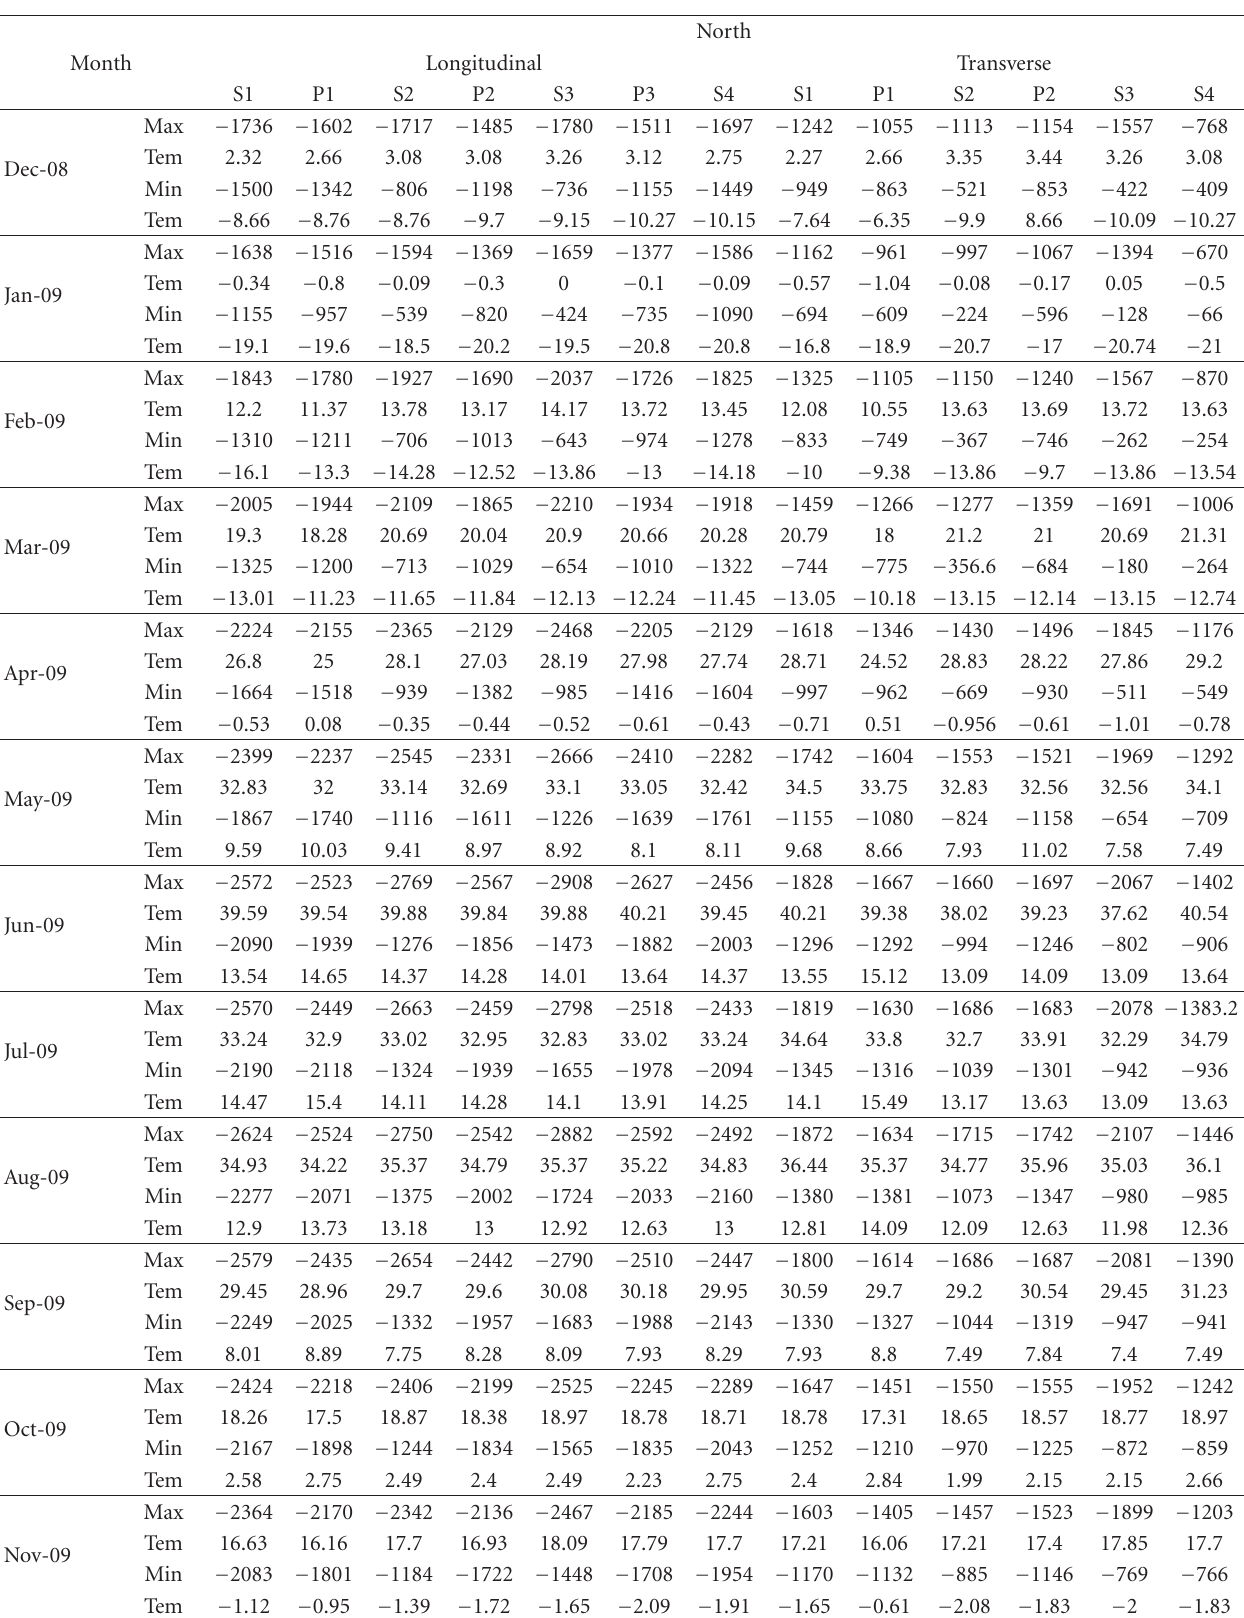
Table 6: Maximum and minimum stresses—north (psi) ∗